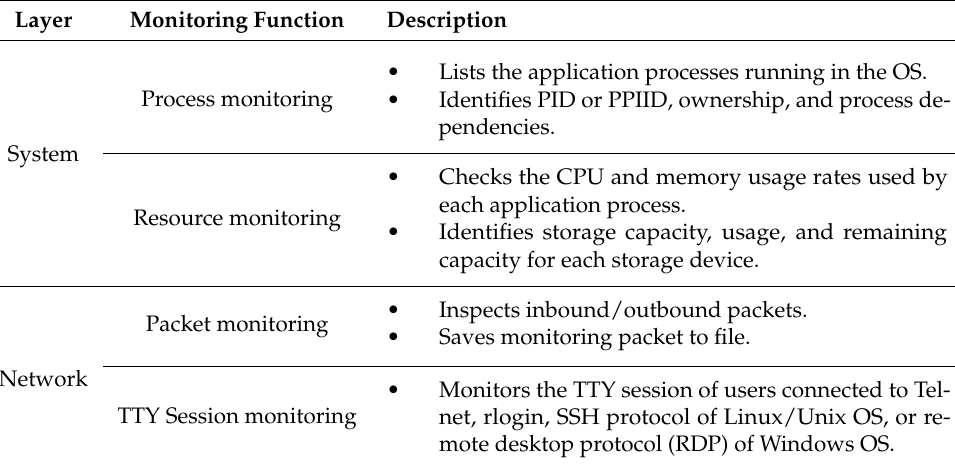
Table 1. Monitoring functions provided by